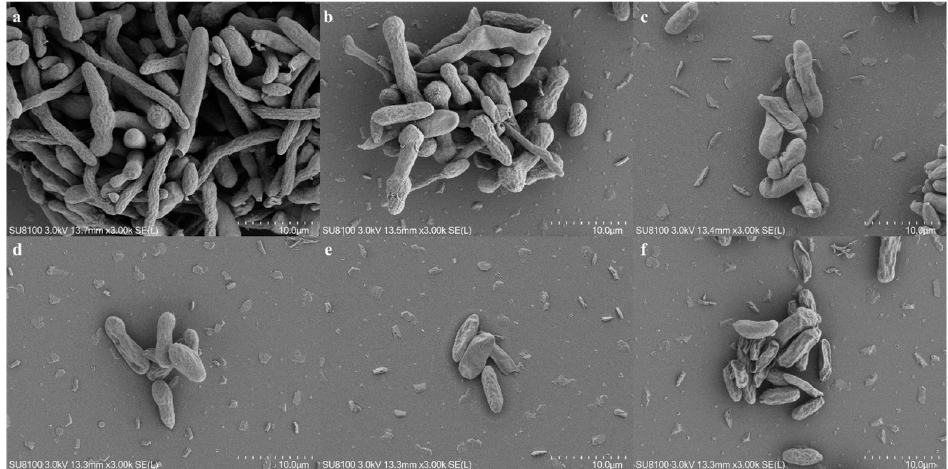
Figure 3. Morphological change of FON conidia exposed to various concentrations of iturin A. ( a ) 0 μ g/mL, control; ( b ) 30 μ g/mL; ( c ) 60 μ g/mL; ( d ) 90 μ g/mL; ( e ) 120 μ g/mL; ( f ) 150 μ g/mL.